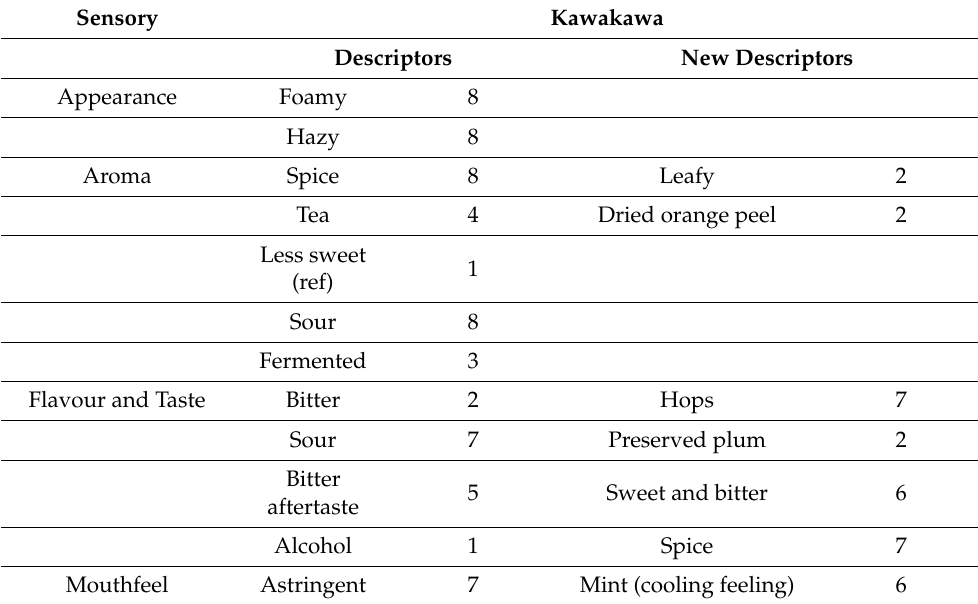
Table 6. The results from the sensory focus group of eight panellists. The descriptors were based on